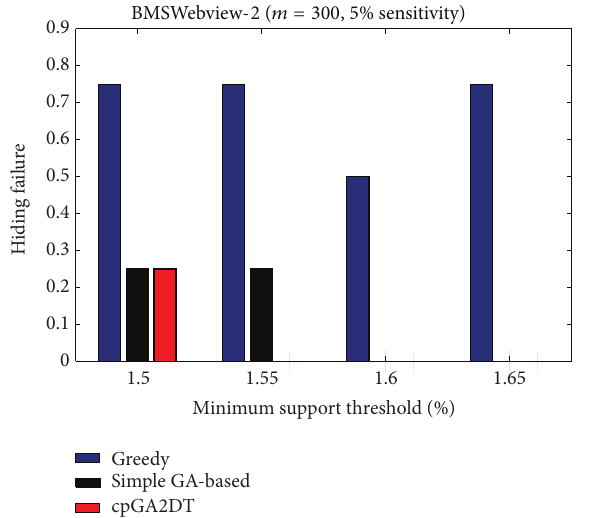
Figure 18: Comparisons of hiding failure at various minimum support thresholds for BMSWebview-2 database.